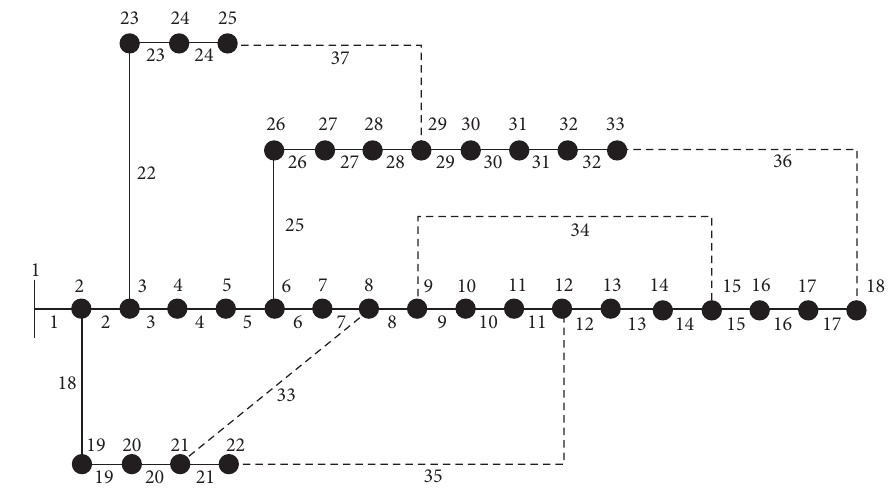
Figure 2: Te IEEE 33-node system. Table 1: Comparisons of ISOS and other techniques in solving 33-node